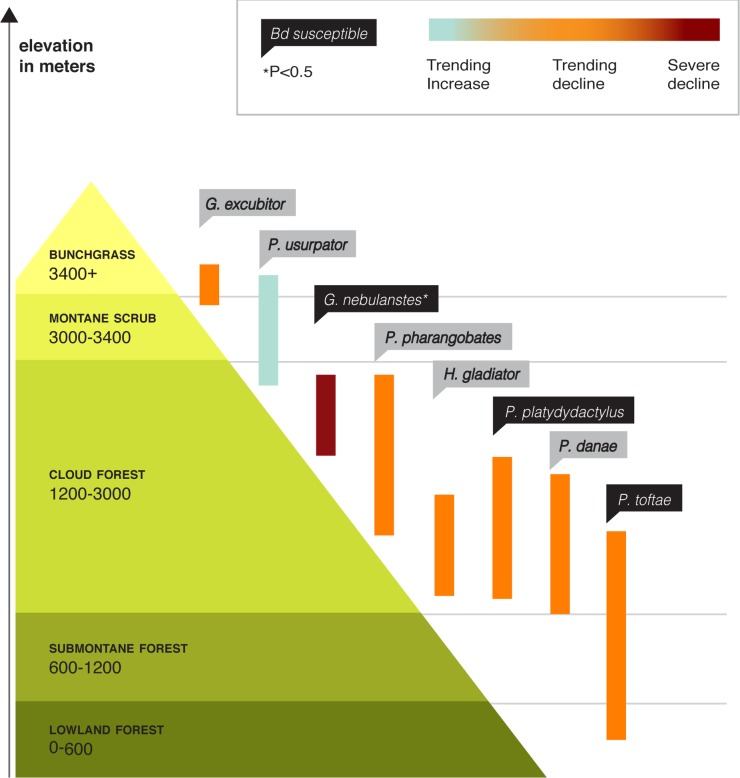
Elevational ranges and summary of findings for the species examined in this study.The eight species examined in this study are among the 36 species surviving out of originally 55 species distributed from 1200 to 3800 m prior to the Bd epizootic. The mountain shown is the Amazonian slope of the Cordillera de Paucartambo, Cusco, near Manu National Park, Peru. Species found to be susceptible to Bd are indicated and population survey results from pre and post-epizootic are shown.